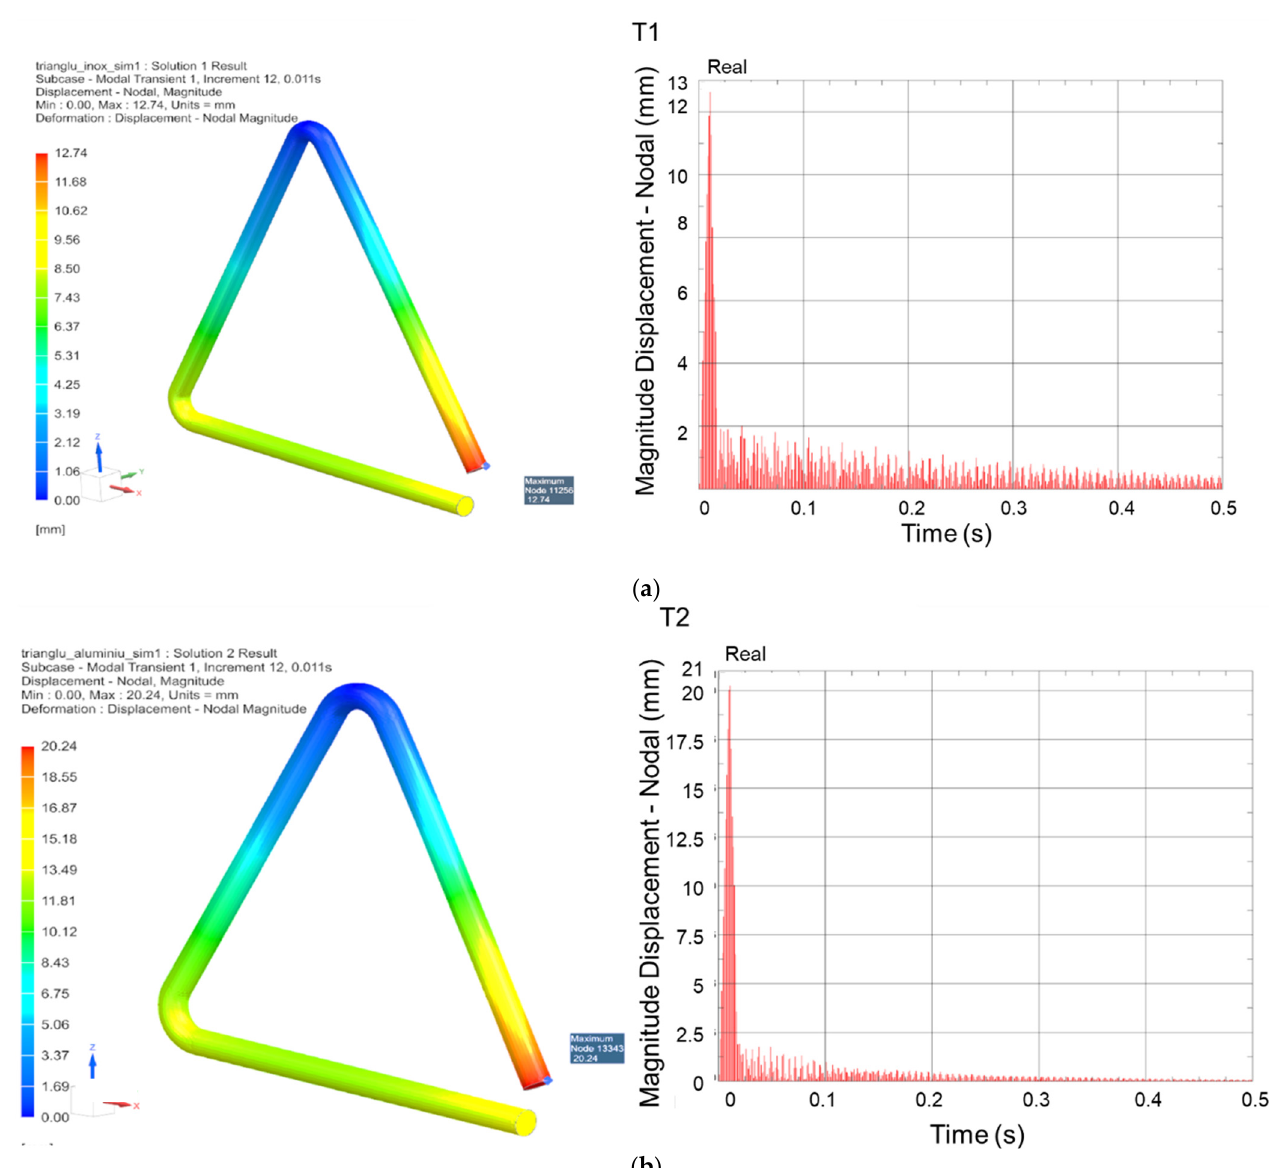
Figure 14. Modal transient response: ( a ) triangle T1; ( b ) triangle T2.